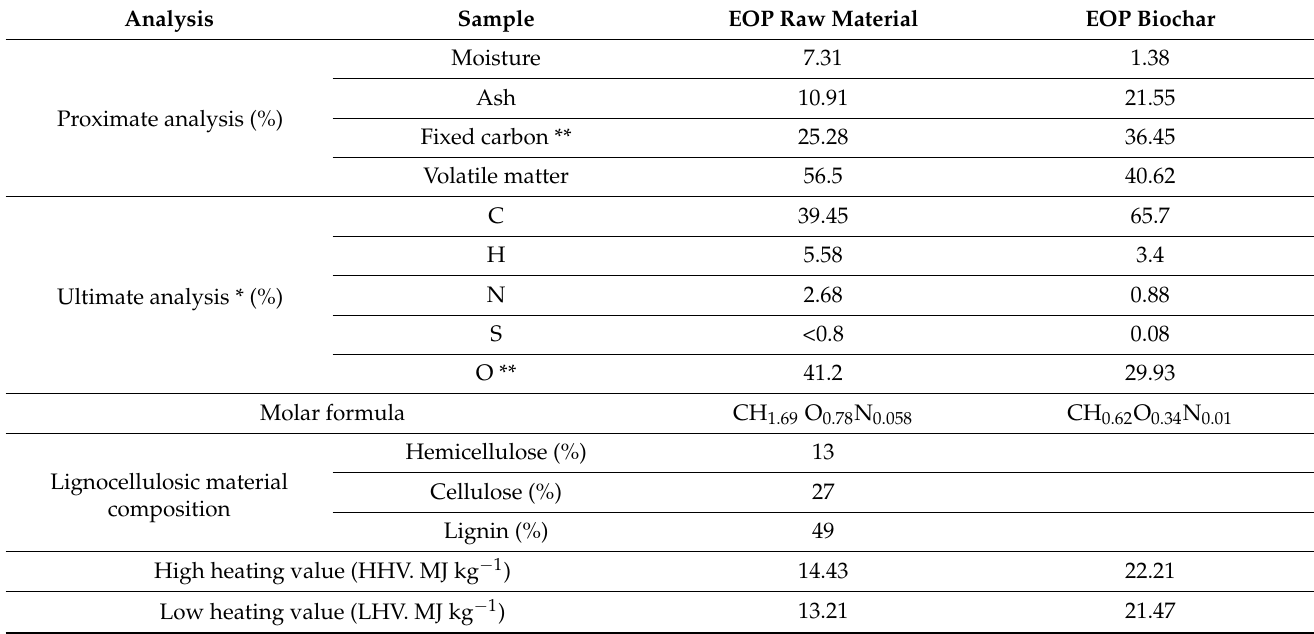
Table 1. Proximate and elemental analysis of the EOP raw material and its derived biochar.